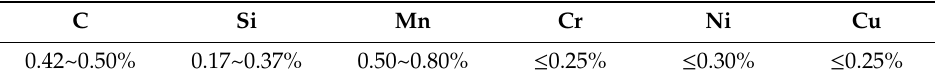
Table 1. Chemical composition of 45 steel (mass fraction).